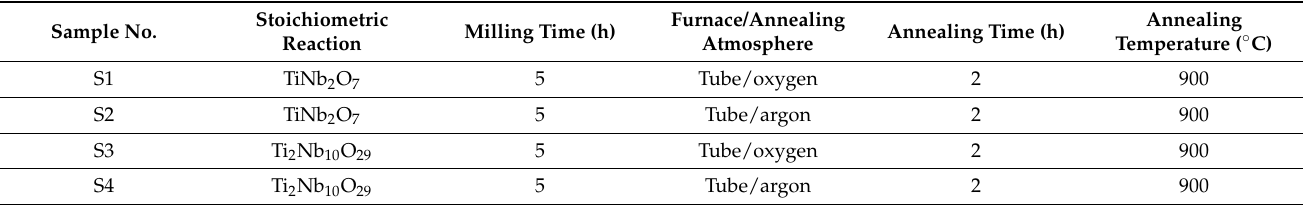
Table 1. Specifications of the applied parameters in the experimental process. Sample